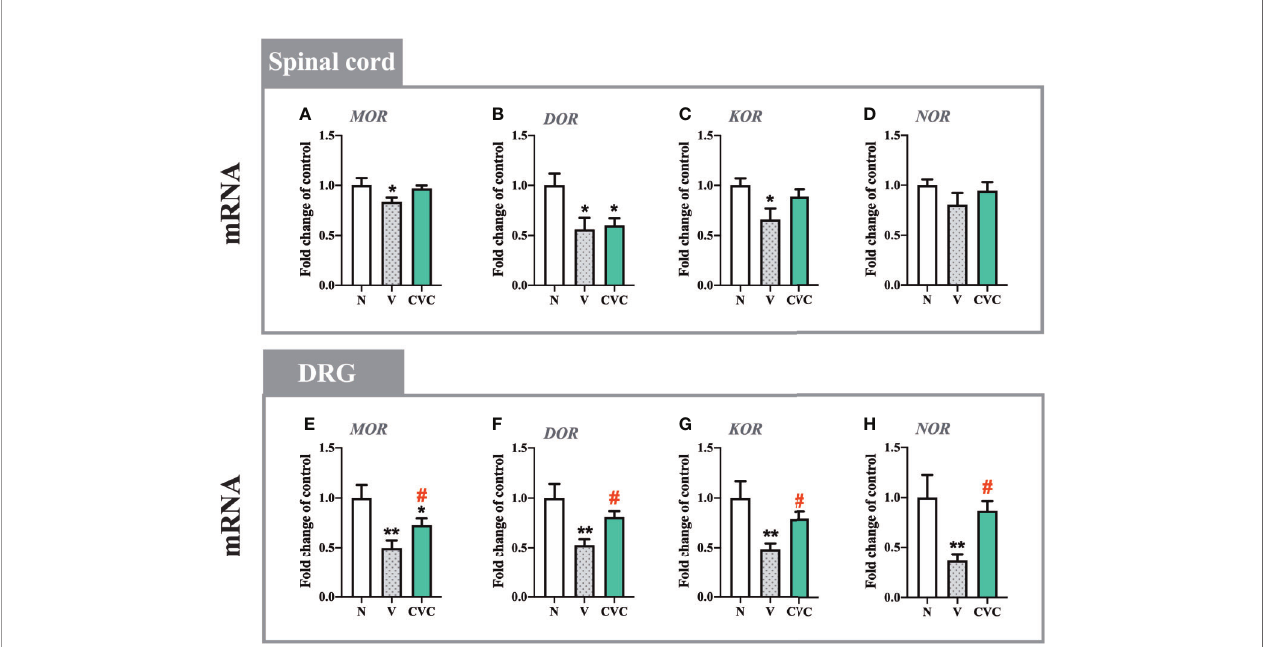
FIGURE 7 | Changes in mRNA levels of MOR , DOR , KOR and NOR in the spinal cord (A – D) and DRG (E – H) on day 7 post CCI after repeated vehicle or cenicriviroc (20 µg/5 µl, i.t. ) administration, measured using RT-qPCR method. Data are presented as the mean ± SEM (n = 4 – 8 per group). Intergroup differences were analyzed by ANOVA with Bonferroni ’ s multiple comparisons test. **p < 0.01, *p < 0.05 indicate differences between naive and V-treated/CVC-treated CCI-exposed rats; # p < 0.05 indicates differences between V-treated and CVC-treated CCI-exposed rats. CCI, chronic constriction injury; CVC, cenicriviroc; N, naive; V,